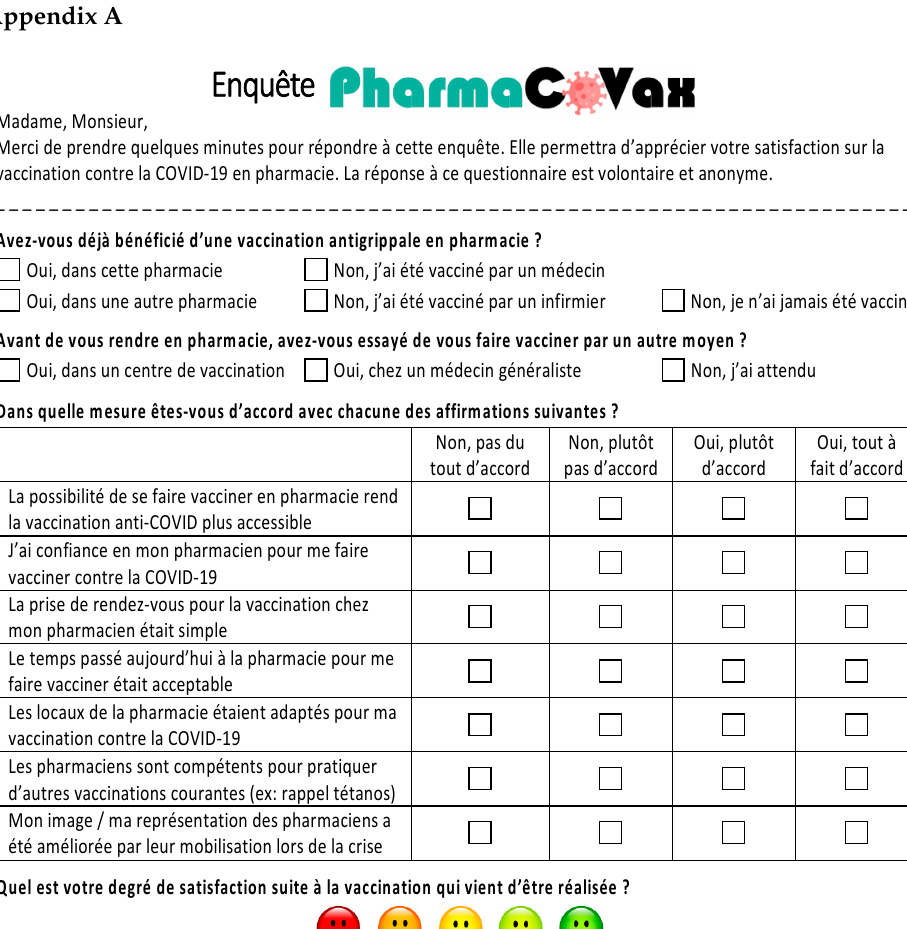
Figure A1. French PharmaCoVax Survey